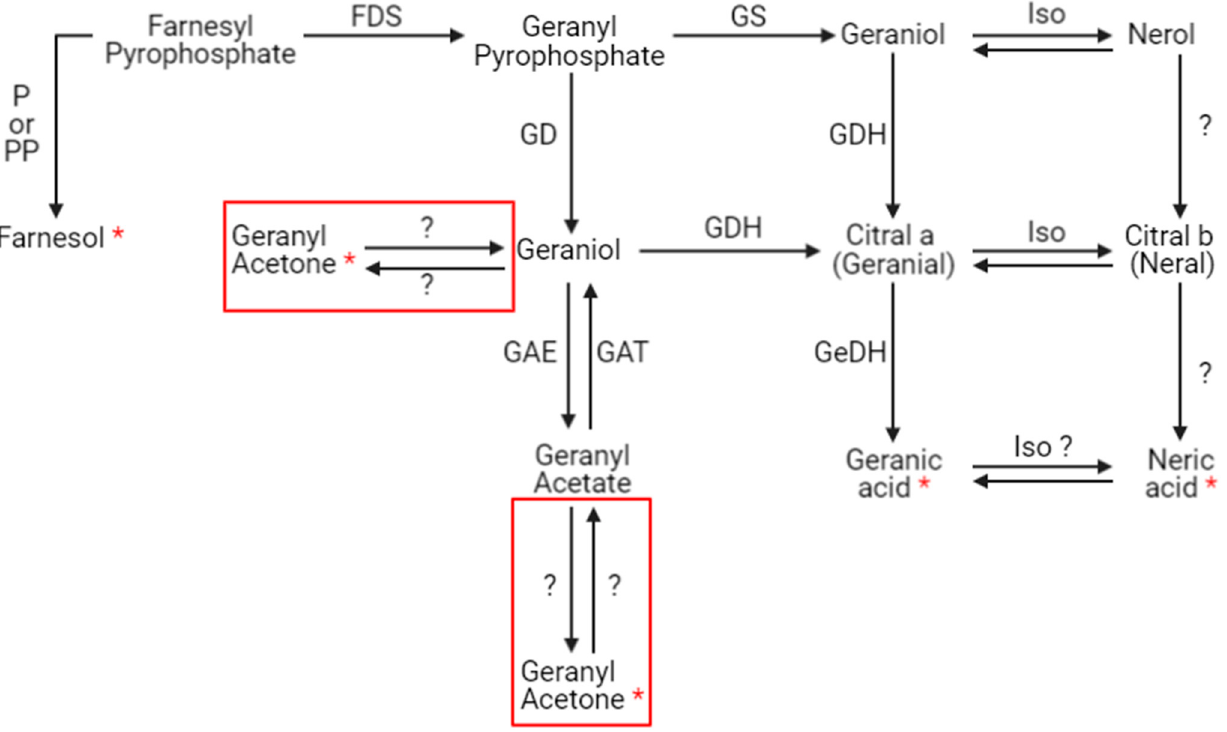
Figure 7 . Putative Nasonov gland metabolic pathway. Seven compounds produced in the Nasonov gland are known to have semiochemical activities: farnesol, geraniol, nerol, geranial, neral, geranic acid, and neric acid. Question marks represent hypothetical transformations. Red frames containing geranyl acetone represent these two hypothetical synthesis pathways. P = phosphatase, PP = pyrophosphatase, FDS = farnesyl diphosphate synthase (or farnesyl pyrophosphate synthase), GD = geranyl diphosphatase (or geranyl pyrophosphatase), GAE = geranyl acetate esterase, GAT = geranyl acetyl transferase, GS = geraniol synthase, GDH = geraniol dehydrogenase, Iso = isomerase, and GeDH = geranial dehydrogenase (according to [43–45,47–49]). Red stars represent compounds related to the Nasonov gland pathway identified in the volatolome analysis.